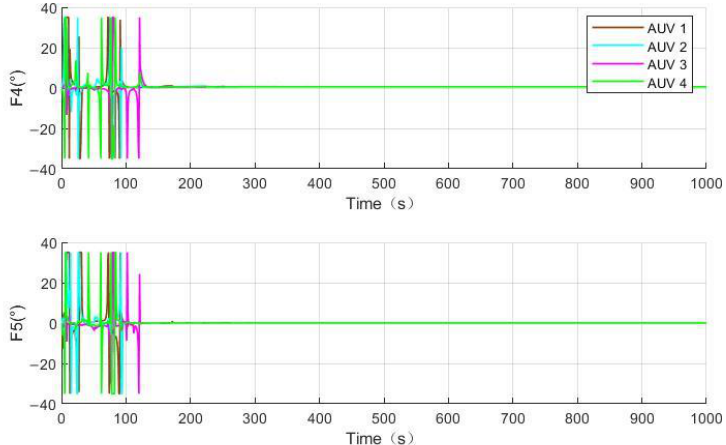
Figure 16. Rudder angle of the nonlinear model of the followers.